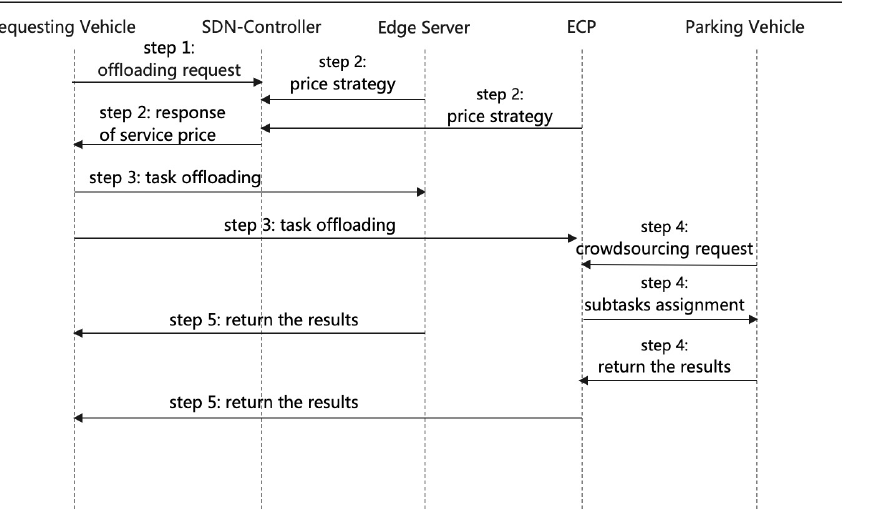
Figure 2. Task offloading steps in parking vehicles assisted edge